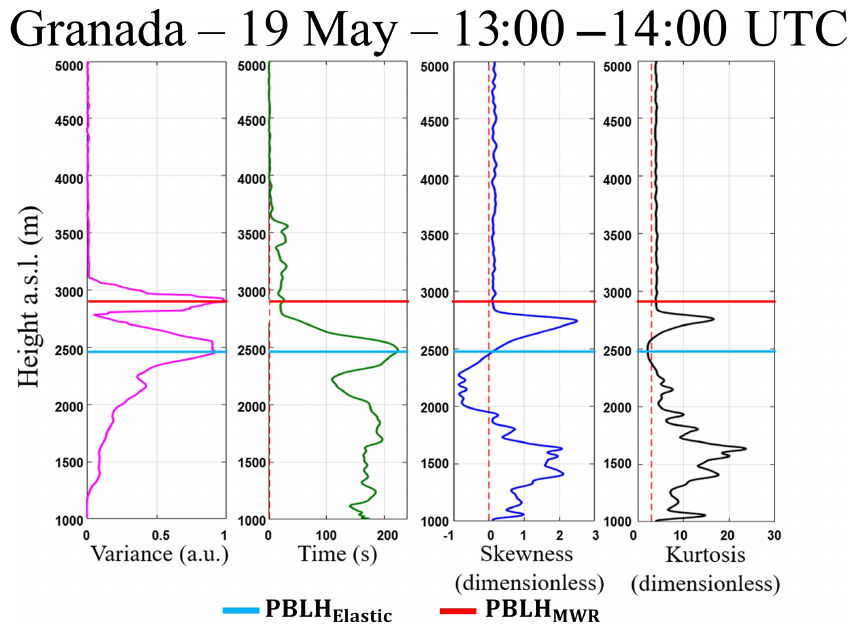
Figure 12. Statistical moments obtained from 532nm wavelength data of elastic lidar (MULHACÉN) in Granada from 13:00 to 14:00UTC on 19 May 2016. From left to right is the variance ( σ 2 ), integral timescale ( τ RCS (cid:48) ]), skewness ( S RCS (cid:48) ) and kurtosis ( K RCS (cid:48) ). RCS (cid:48)